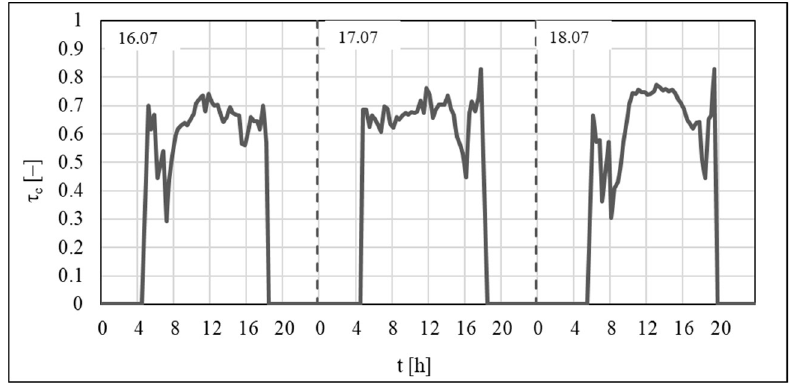
Figure 11. Changes of irradiance on days 16th to 18th of July.